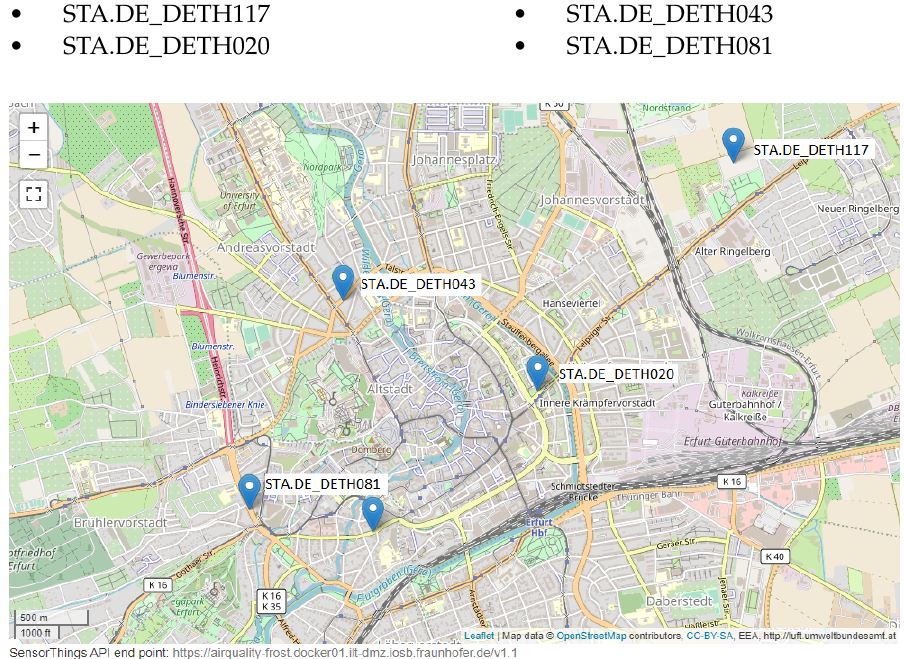
Figure 2. Location of the sensors in the city of